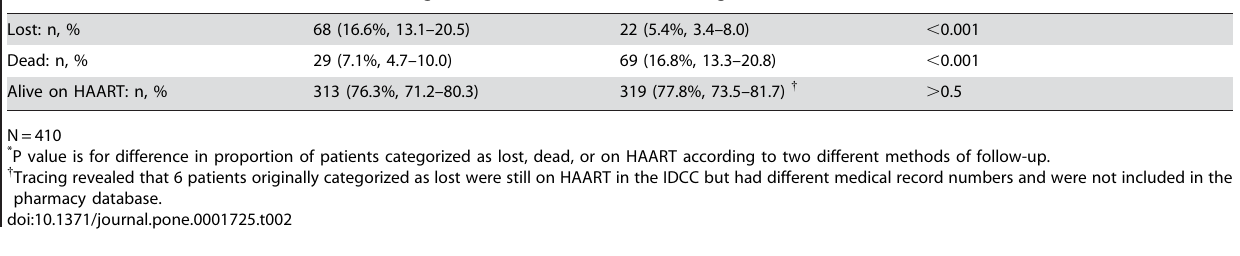
Outcome Before tracing (95% CI) After tracing (95%